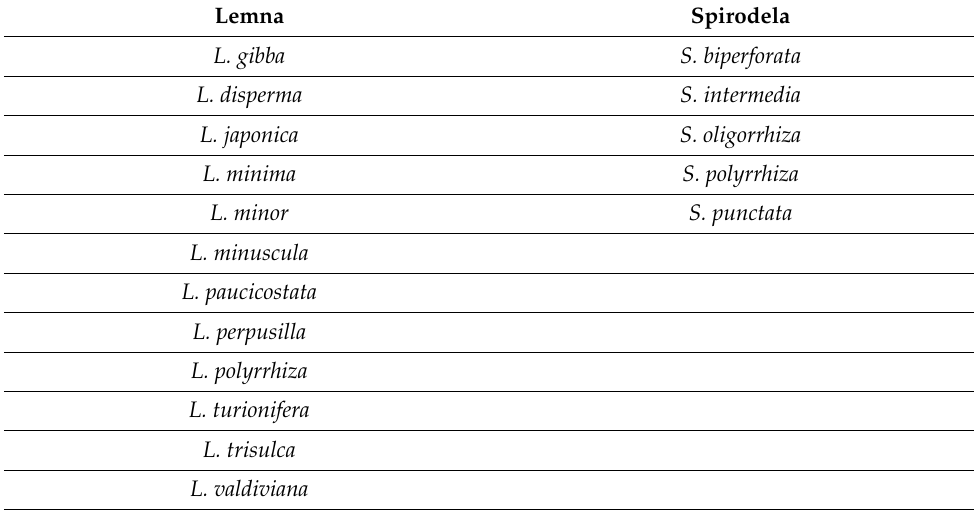
Table 1. Selected plant species of the Lemnaceae family (only Lemna and Spirodela ). Lemna Spirodela L.